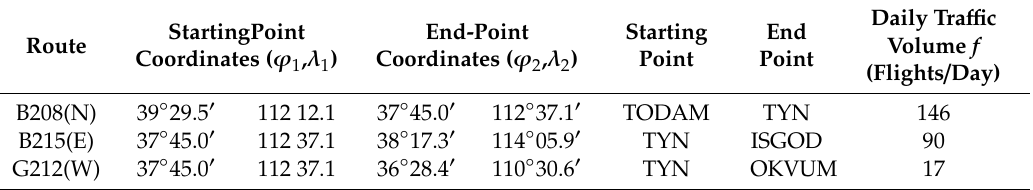
Table 1. Examples of the route network and daily traffic volume.